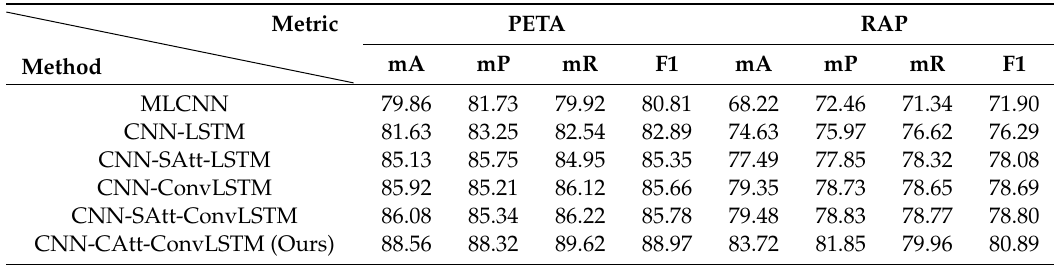
Table 2. Experimental result on the e ff ect of ConvLSTM and